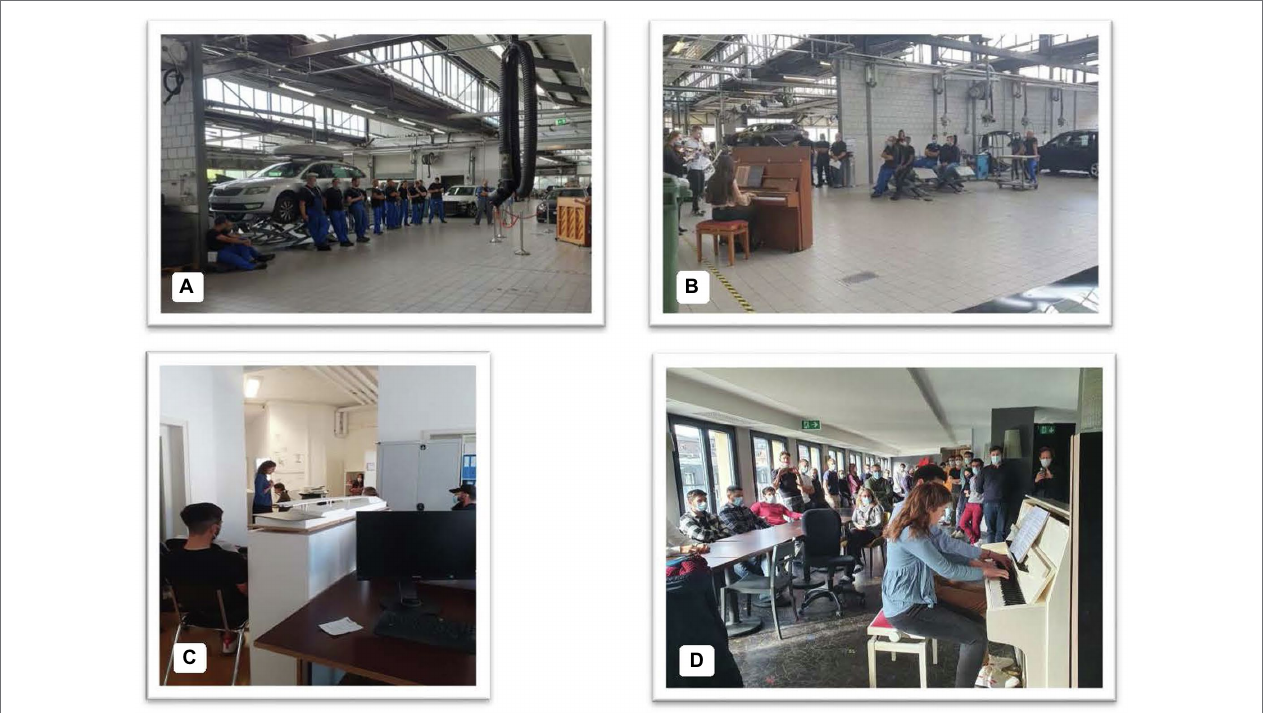
FIGURE 2 | Ritualization. Car garage, first (A) and last (B) concert; Engineering office, fourth (C) and ninth (D)